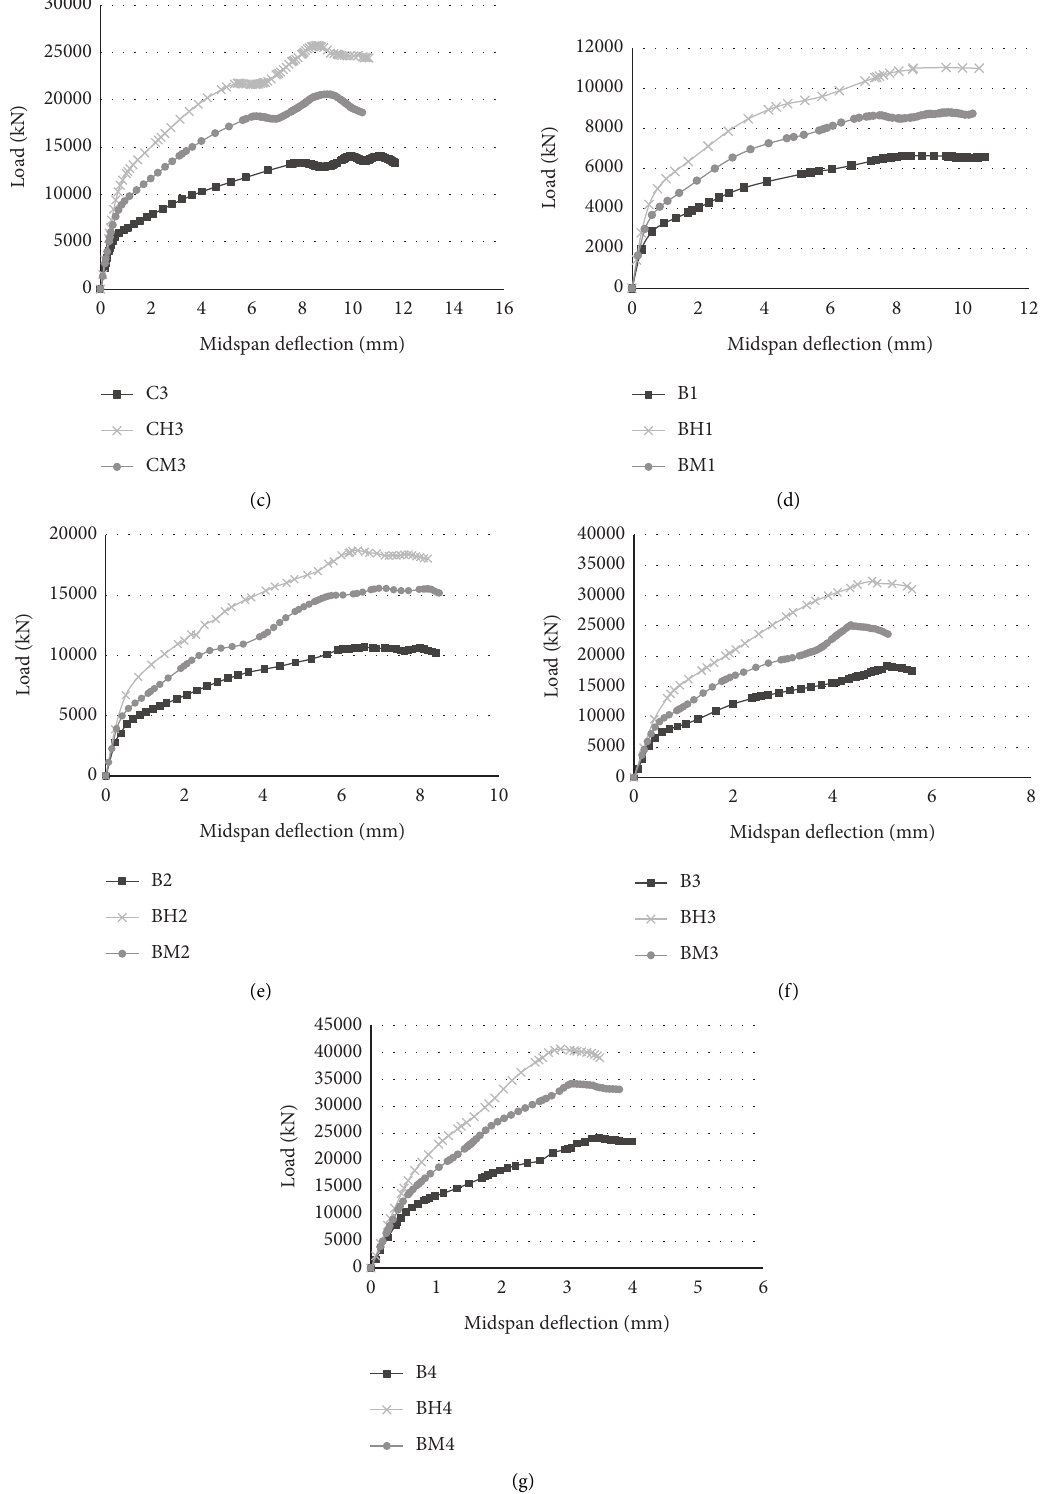
c ′ . (a) C1, CM1, and CH1. (b) C2, CM2, and